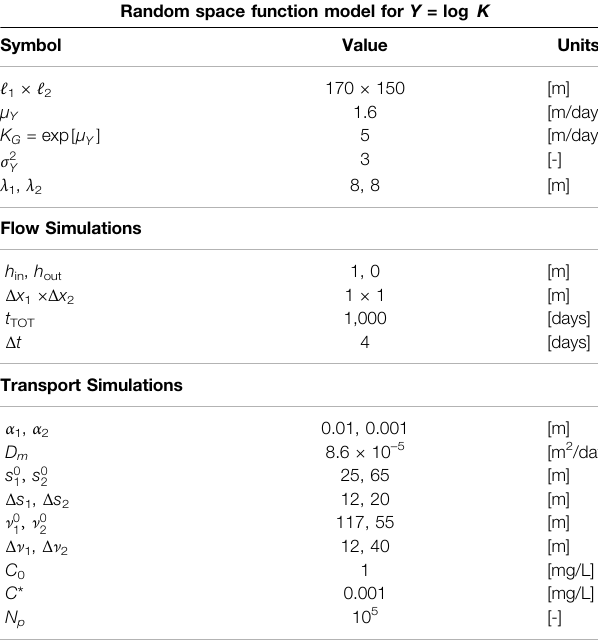
TABLE 1 | Input parameters used in the proposed tutorial for hydraulic conductivity fi eld generation and fl ow and transport simulations. Random space function model for Y = log K